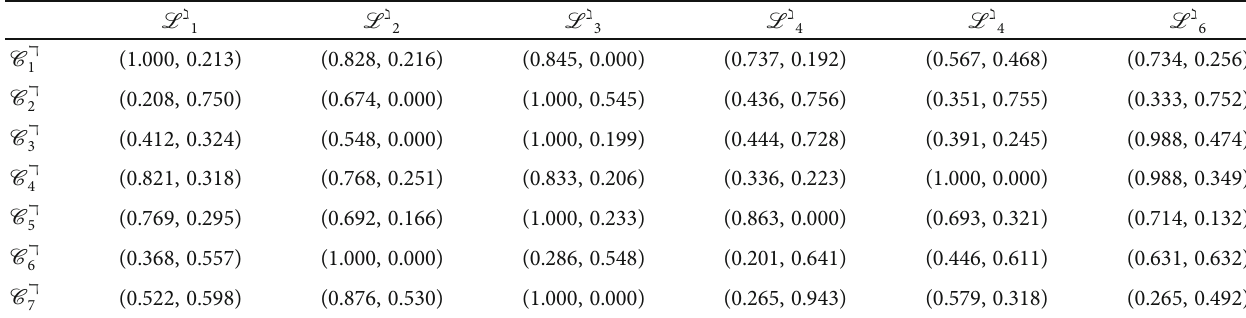
Table 6: Normalized decision matrix.